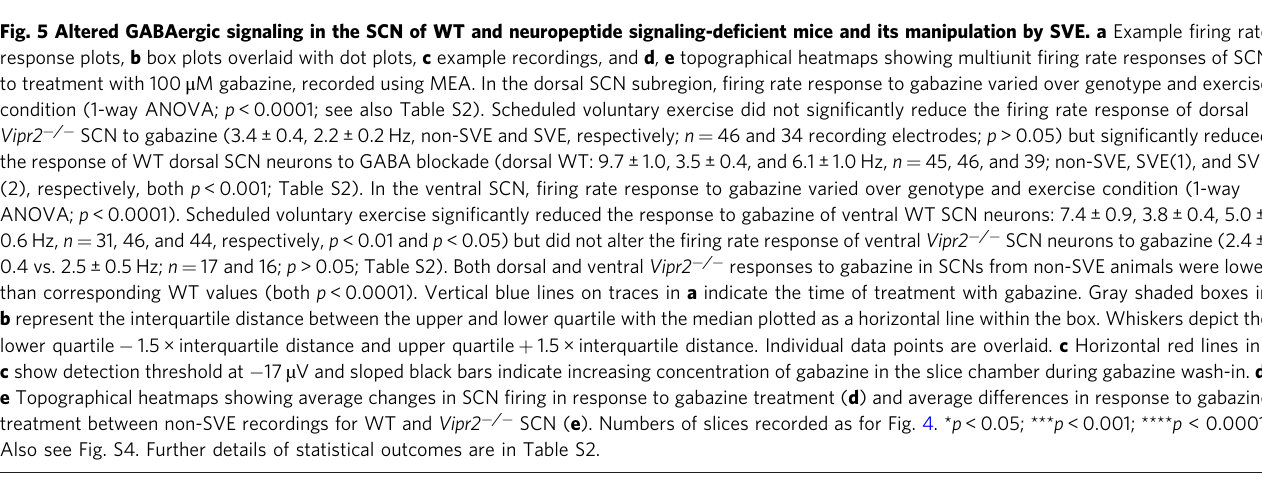
Fig. 5 Altered GABAergic signaling in the SCN of WT and neuropeptide signaling-de fi cient mice and its manipulation by SVE. a Example fi ring rate response plots, b box plots overlaid with dot plots, c example recordings, and d , e topographical heatmaps showing multiunit fi ring rate responses of SCN to treatment with 100 μ M gabazine, recorded using MEA. In the dorsal SCN subregion, fi ring rate response to gabazine varied over genotype and exercise condition (1-way ANOVA; p < 0.0001; see also Table S2). Scheduled voluntary exercise did not signi fi cantly reduce the fi ring rate response of dorsal Vipr2 − / − SCN to gabazine (3.4 ± 0.4, 2.2 ± 0.2 Hz, non-SVE and SVE, respectively; n = 46 and 34 recording electrodes; p > 0.05) but signi fi cantly reduced the response of WT dorsal SCN neurons to GABA blockade (dorsal WT: 9.7 ± 1.0, 3.5 ± 0.4, and 6.1 ± 1.0 Hz, n = 45, 46, and 39; non-SVE, SVE(1), and SVE (2), respectively, both p < 0.001; Table S2). In the ventral SCN, fi ring rate response to gabazine varied over genotype and exercise condition (1-way ANOVA; p < 0.0001). Scheduled voluntary exercise signi fi cantly reduced the response to gabazine of ventral WT SCN neurons: 7.4 ± 0.9, 3.8 ± 0.4, 5.0 ± 0.6 Hz, n = 31, 46, and 44, respectively, p < 0.01 and p < 0.05) but did not alter the fi ring rate response of ventral Vipr2 − / − SCN neurons to gabazine (2.4 ± 0.4 vs. 2.5 ± 0.5 Hz; n = 17 and 16; p > 0.05; Table S2). Both dorsal and ventral Vipr2 − / − responses to gabazine in SCNs from non-SVE animals were lower than corresponding WT values (both p < 0.0001). Vertical blue lines on traces in a indicate the time of treatment with gabazine. Gray shaded boxes in b represent the interquartile distance between the upper and lower quartile with the median plotted as a horizontal line within the box. Whiskers depict the lower quartile − 1.5 × interquartile distance and upper quartile + 1.5 × interquartile distance. Individual data points are overlaid. c Horizontal red lines in c show detection threshold at − 17 µ V and sloped black bars indicate increasing concentration of gabazine in the slice chamber during gabazine wash-in. d , e Topographical heatmaps showing average changes in SCN fi ring in response to gabazine treatment ( d ) and average differences in response to gabazine treatment between non-SVE recordings for WT and Vipr2 − / − SCN ( e ). Numbers of slices recorded as for Fig. 4. * p < 0.05; *** p < 0.001; **** p < 0.0001. Also see Fig. S4. Further details of statistical outcomes are in Table